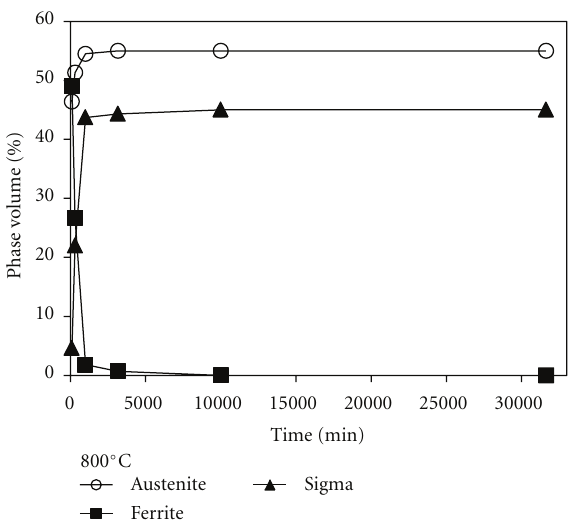
Figure 3: Changes in volume% of austenite, ferrite and sigma phases with ageing time at 800 ◦ C.